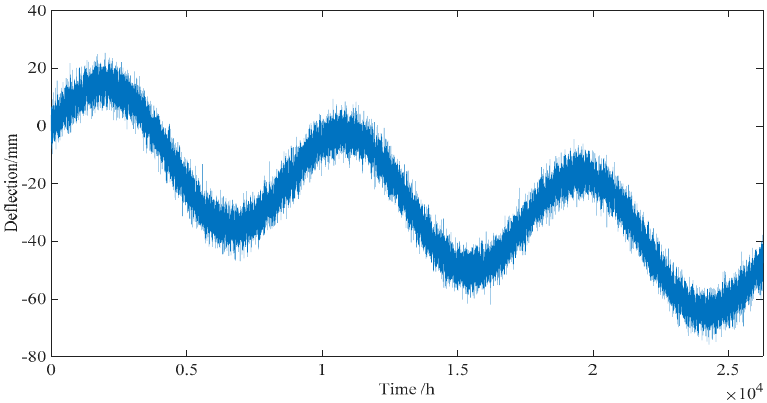
Figure 10. Total deflection of different effects with 10% noise level (not including live load effect).